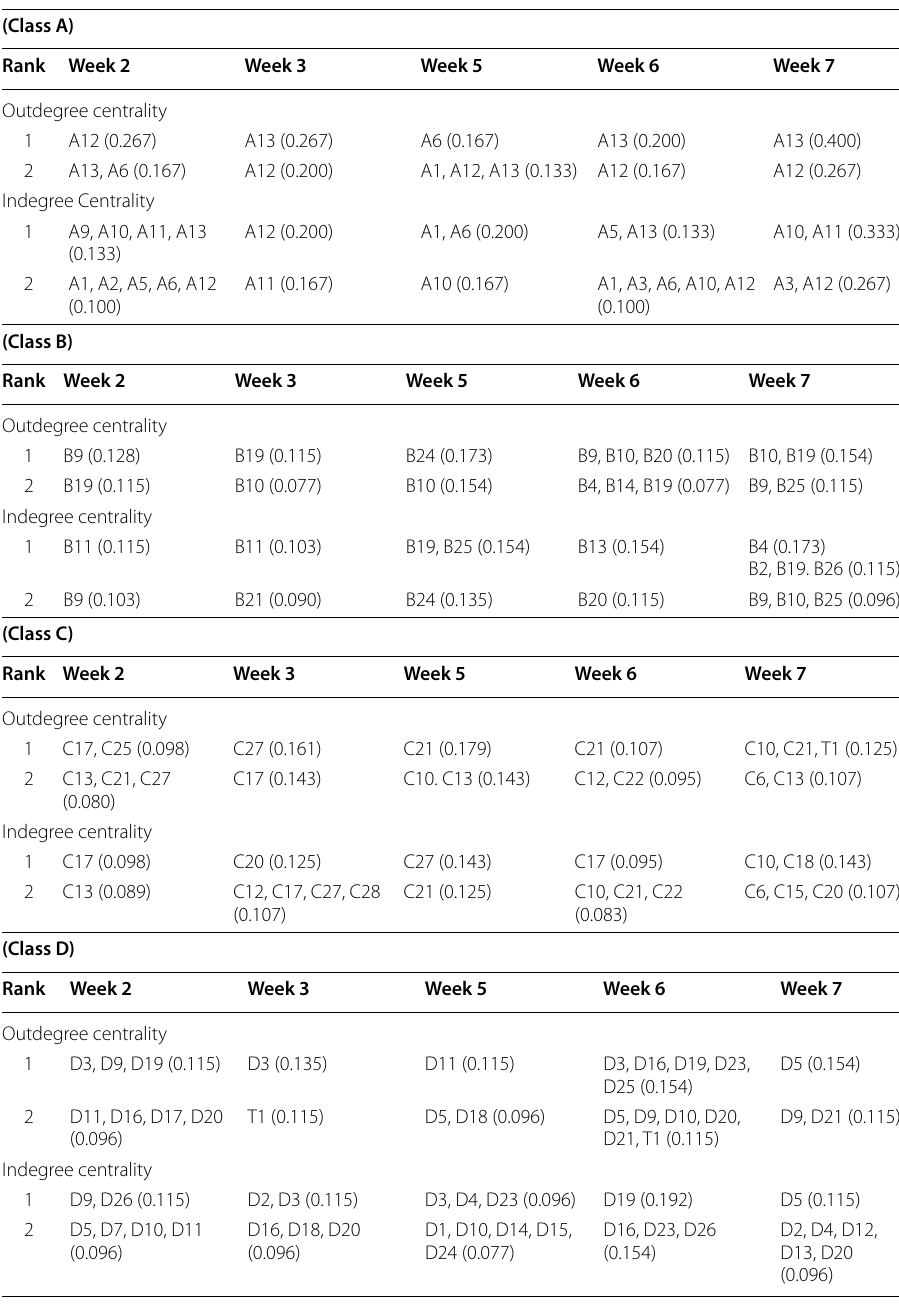
Table 2 Change of outdegree and indegree centrality on weekly discussion boards (Class